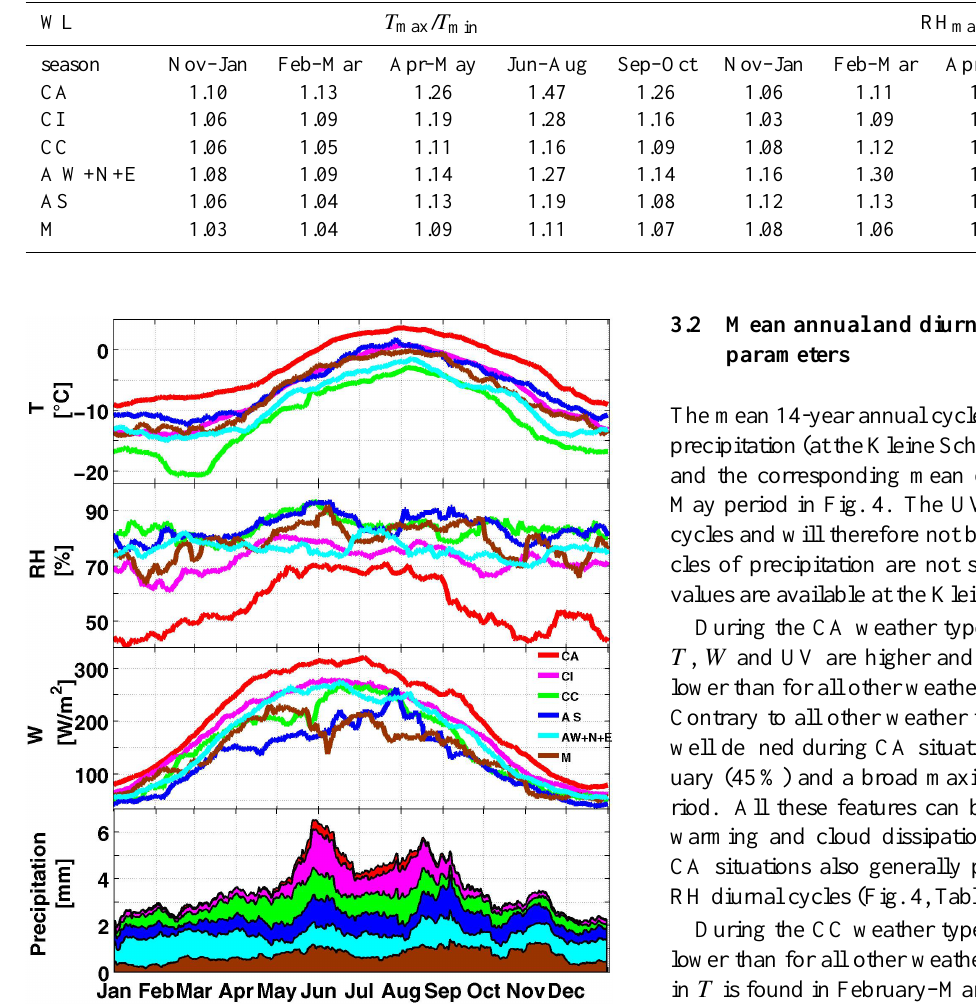
Fig. 3. Mean 1995–2008 annual cycles of the temperature T , the RH, the global short wave radiation W at the JFJ and the precipi- tation at the Kleine Scheidegg as a function of SYNALP weather